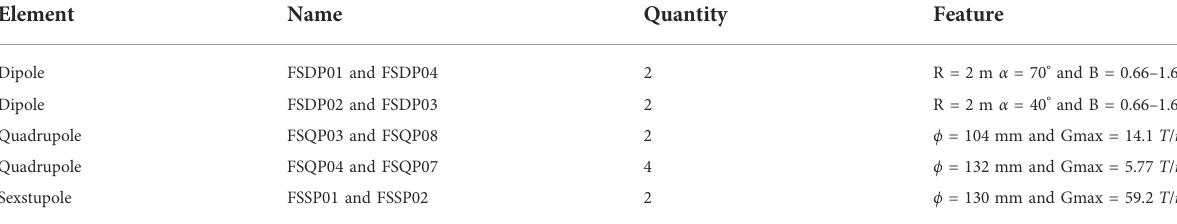
TABLE 1 FRAISE magnetic transport element features